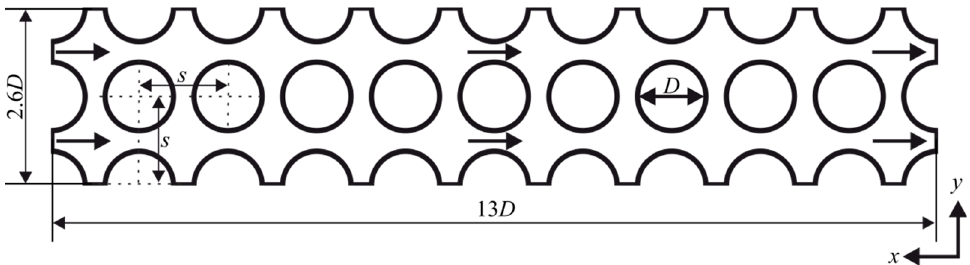
Figure 1. The computational domain.